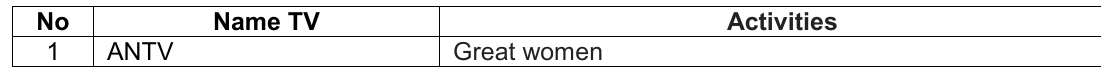
Table 2. UKM that have been covered by Media or